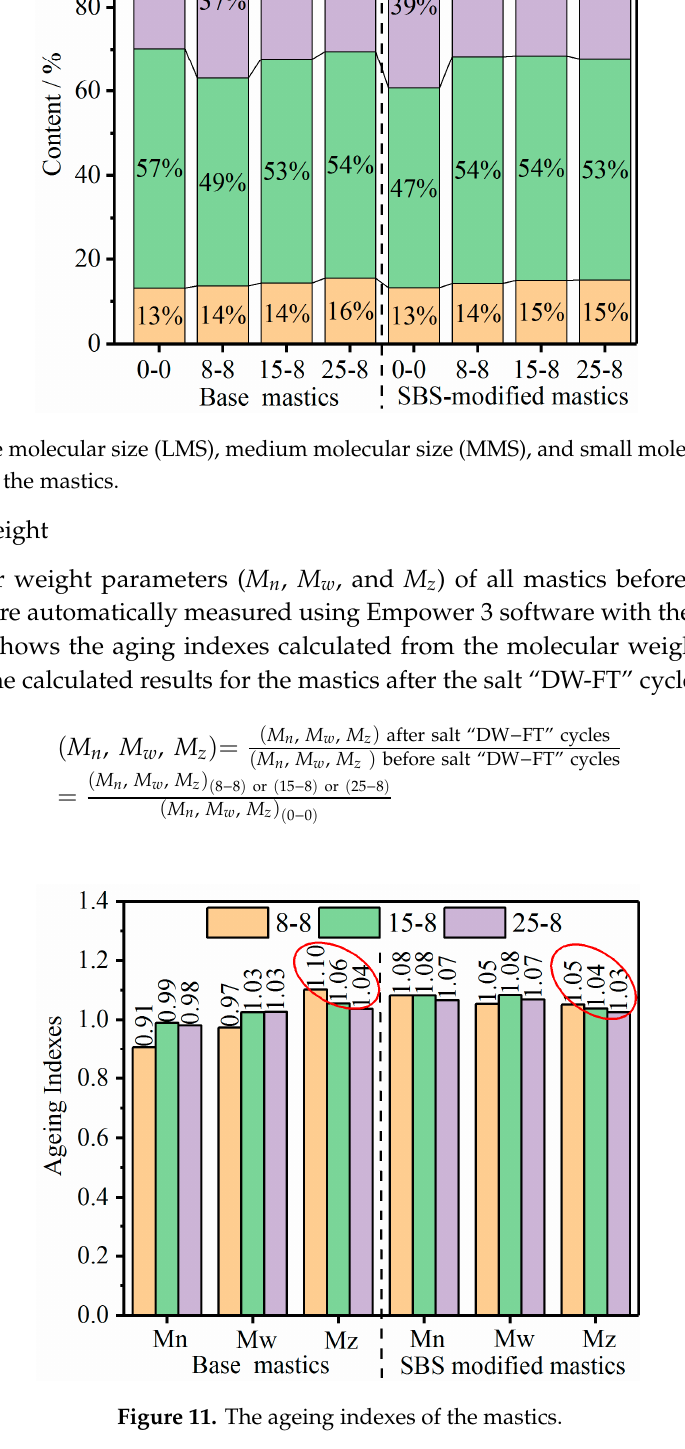
Figure 11. The ageing indexes of the mastics.